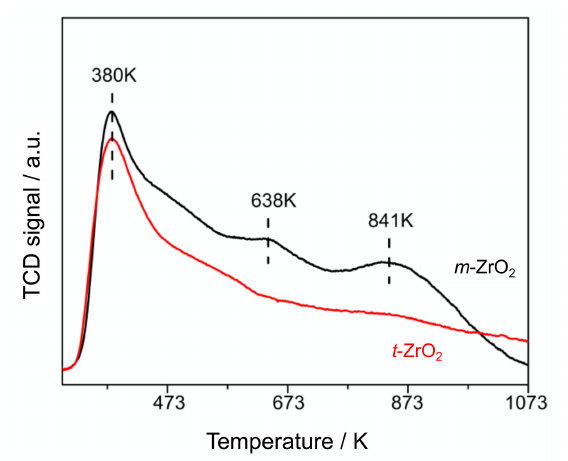
Figure 2. CO-TPD profiles of the ZrO 2 samples.